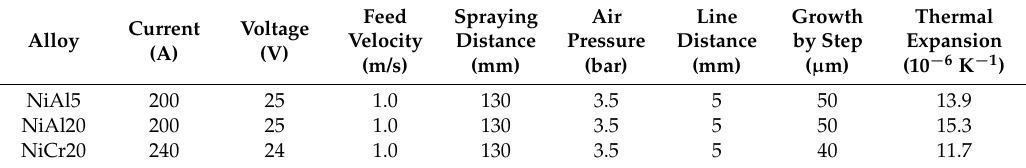
Table 2. Coating materials and parameters used for electric arc wire spraying.